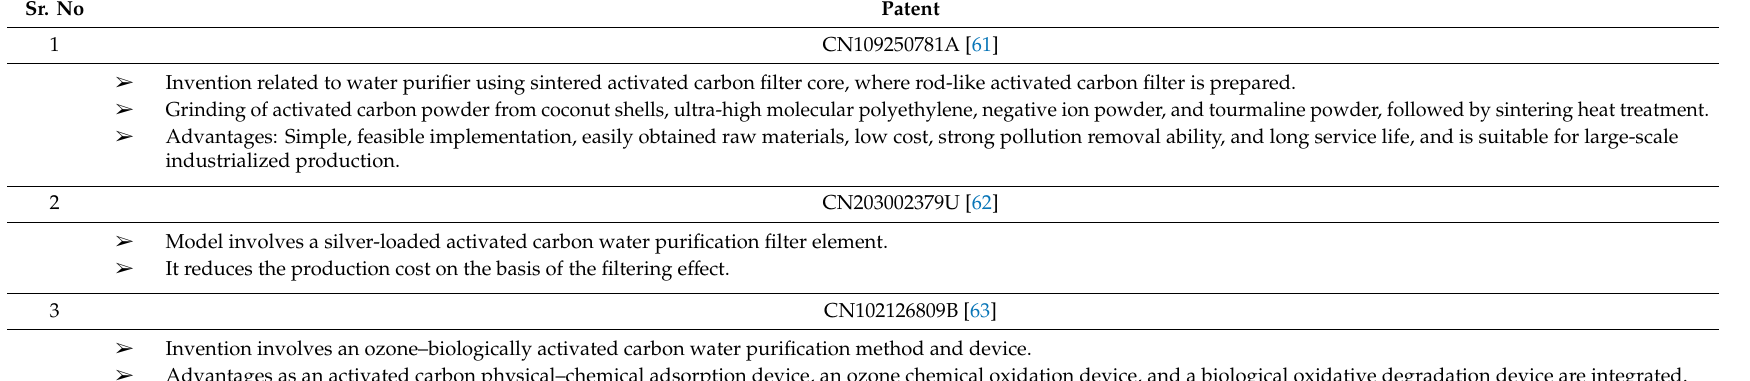
Table 1. Patents for water purification technologies involving carbon-based